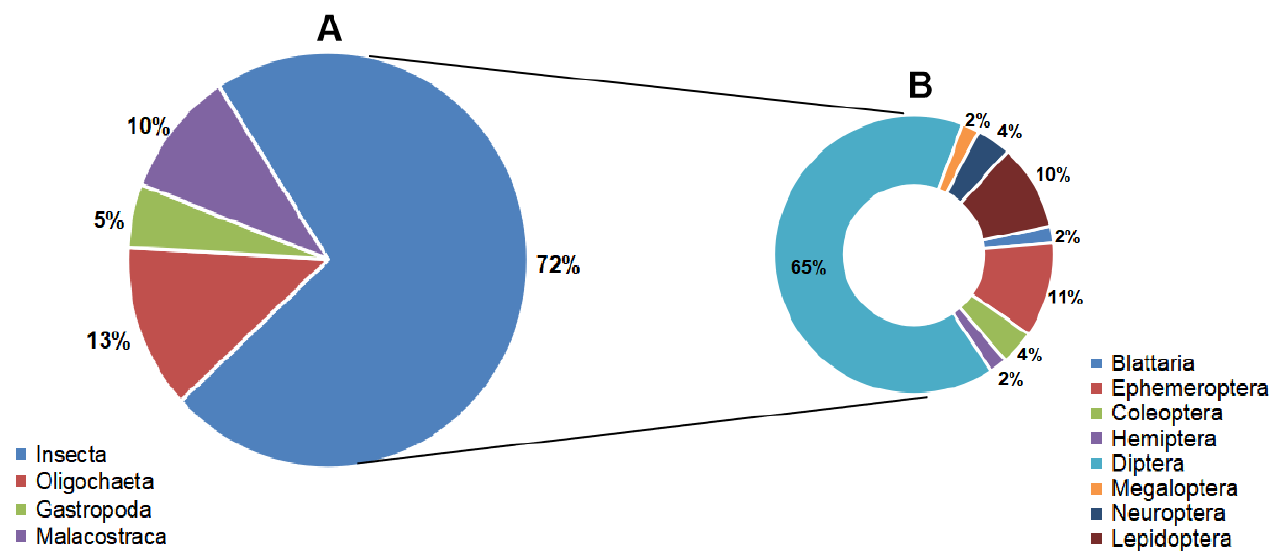
Figure 1. Community composition of macroinvertebrates at the class ( A ) and order ( B ) levels detected by the eDNA technology in the Dongjiang River.